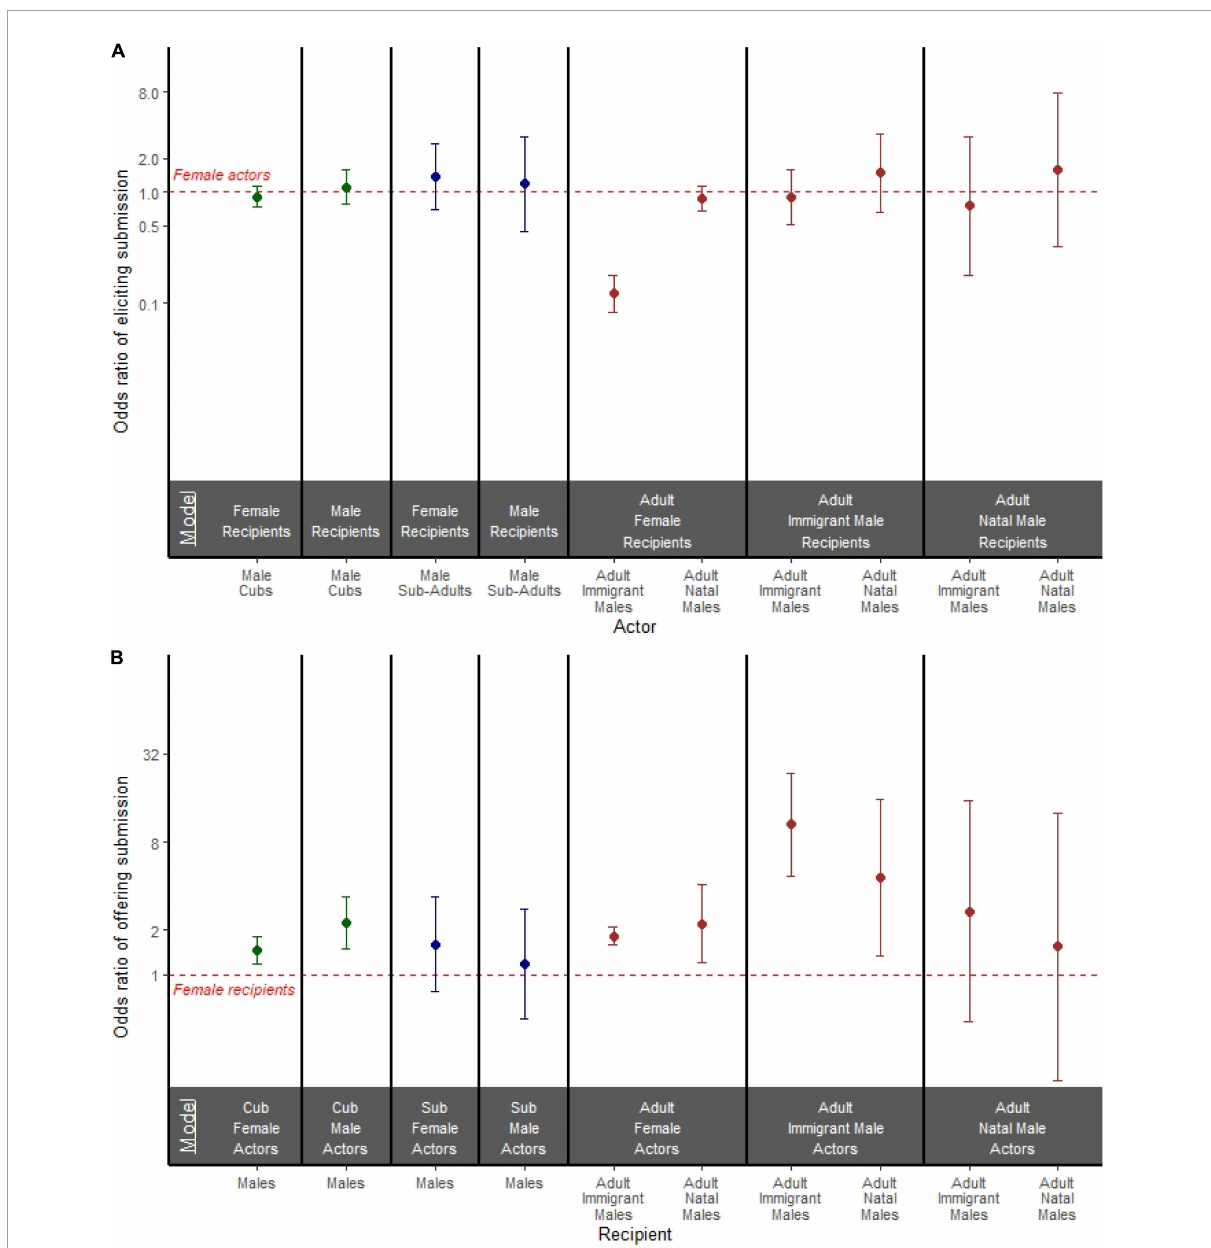
FIGURE3 (A) Odds ratio of an actor eliciting a submissive response in models stratified by both actor age and recipient sex. (B) Odds ratio of a recipient offering a submissive response to aggression in models stratified by both actor age and actor sex. (A,B) Models are separated by bold black lines, and age is depicted by color where cubs are green, subadults are blue, and adults are brown. Points represent the odds ratio and error bars represent 95% confidence intervals around the odds ratio. Each point is compared to a female reference group of the same age class represented by the red dashed